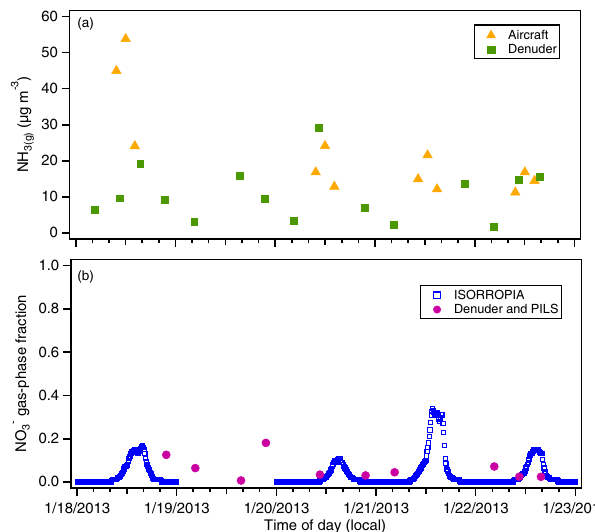
Figure D1. (a) Time series of NH 3 (g) (µgm − 3 ) measured with the denuder at the surface (green squares) and at the lowest altitudes by the chemical ionization mass spectrometer onboard P3-B aircraft (yellow triangles). (B) The nitrate gas-phase fraction estimated by ISORROPIA (blue squares) and the observed fraction determined from the denuder HNO 3 ( g ) and PILS NO − measurements (pink 3 ( p ) circles) (Parworth et al.,